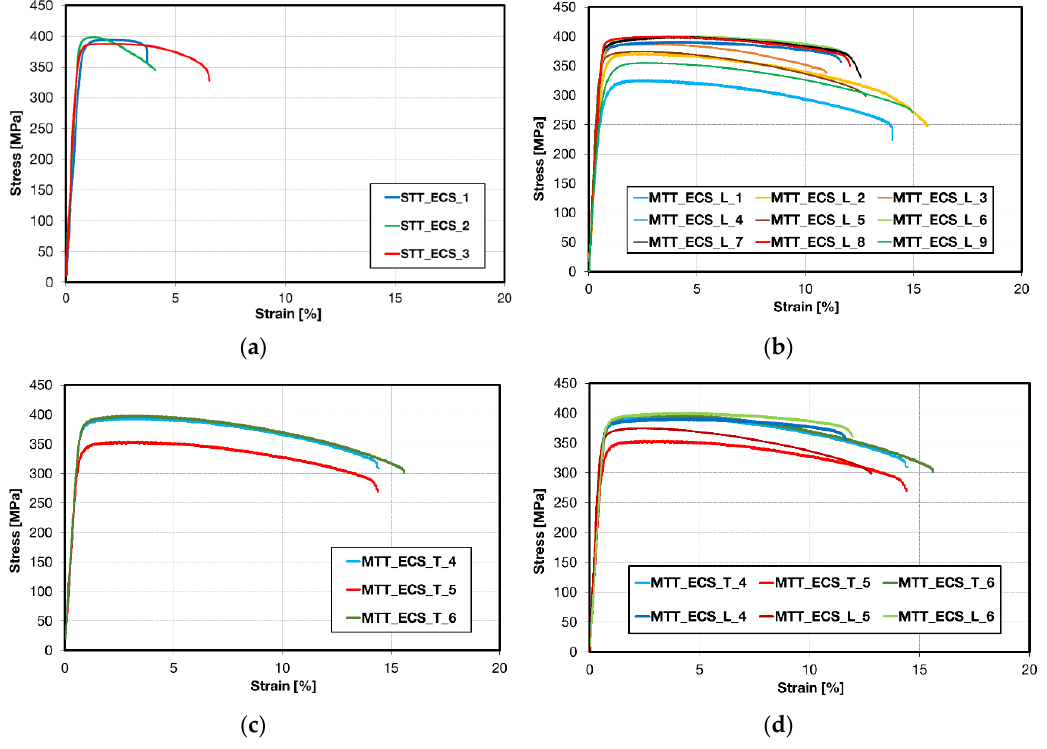
Figure 17. Engineering S-S curves of the ECS material: ( a ) S-S curves performed on standard test samples consisting of three repetitions; ( b ) S-S curves performed on miniaturized samples from the upper edge (MTT_ECS_L1) to the bottom edge (MTT_ECS_L9); ( c ) S-S curves performed on samples in the tangential direction; and ( d ) a comparison of S-S curves obtained using MTT samples in the extrusion (L) and the tangential (T) direction are presented.